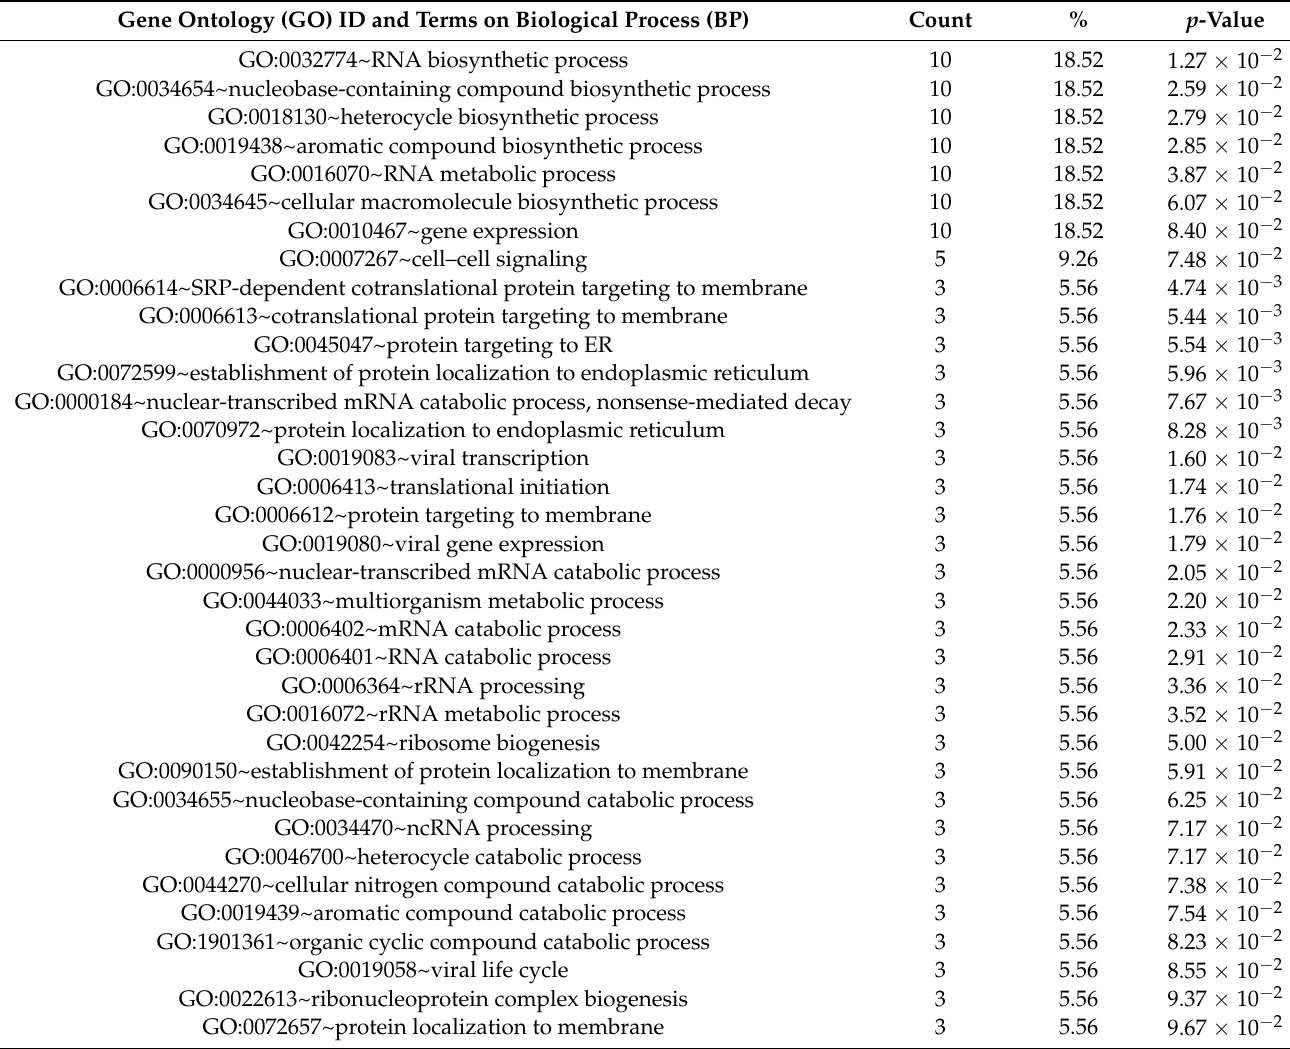
Table 2. The functional analysis of the downregulated genes at 1 h after LLL irradiation. Gene Ontology (GO) ID and Terms on Biological Process (BP)